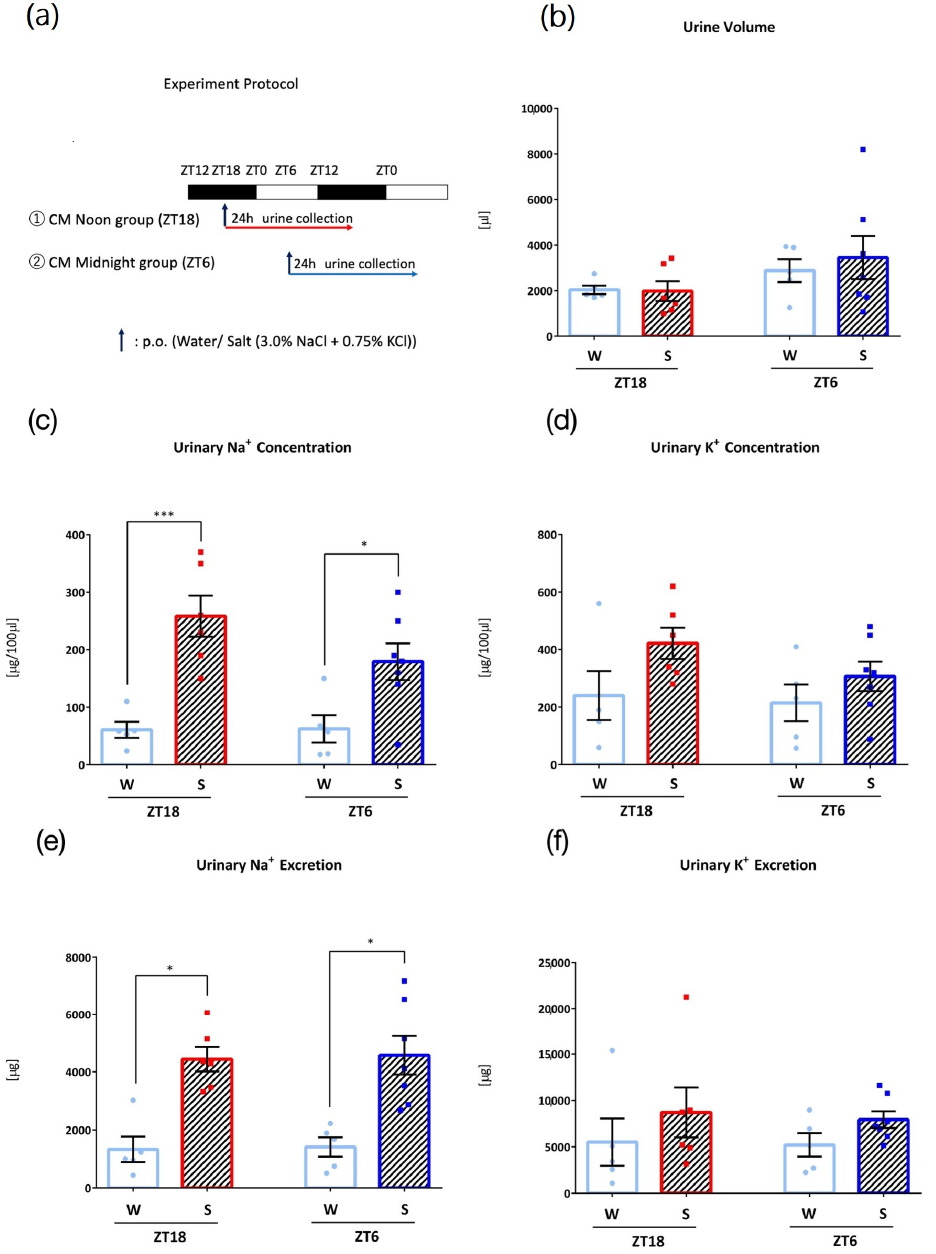
Figure 5. Urinary excretion after administration of salt load in Clock mutant (CM) mice (W: Water administration, S: Salt administration). ( a ) Experimental protocol, ( b ) Urine volume, ( c ) Urinary Na + concentration, * p < 0.05, *** p < 0.001 (vs. Water) Sidak. ( d ) Urinary K + concentration, ( e ) Urinary Na + excretion, * p < 0.05 (vs. Water) Sidak. ( f ) Urinary K + excretion. Data are represented as mean ± SEM (ZT18 group: n = 5–6, ZT6 group: n =